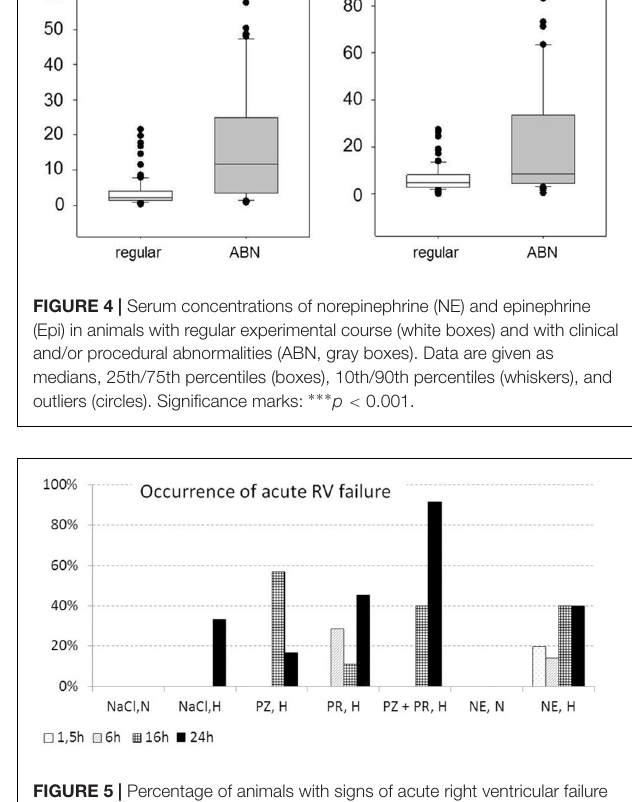
FIGURE 5 | Percentage of animals with signs of acute right ventricular failure (related to total number of animals per group). For explanation of treatment groups see Table 1